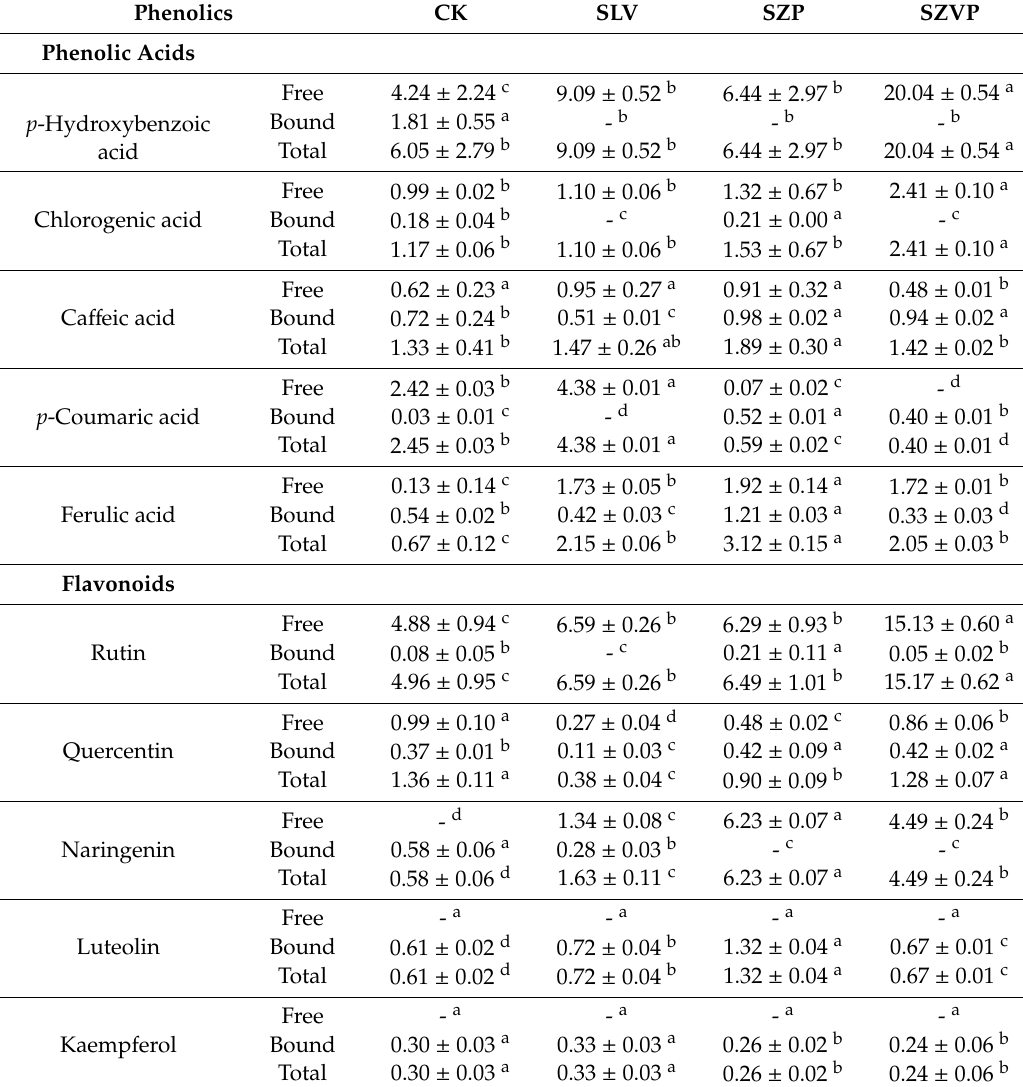
Table 2. The contents of extractable and bound phenolics in goji juices (mg / 100